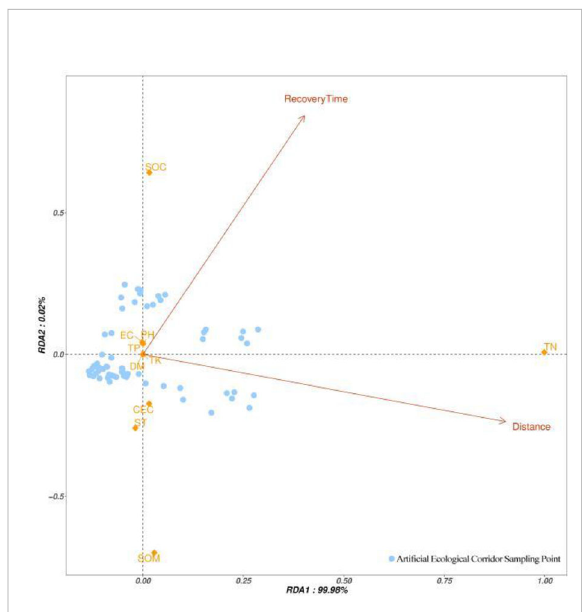
FIGURE 6 The samples collected within the ecological corridor distance from the Ashe River> 30 m and recovery time > 5 a.